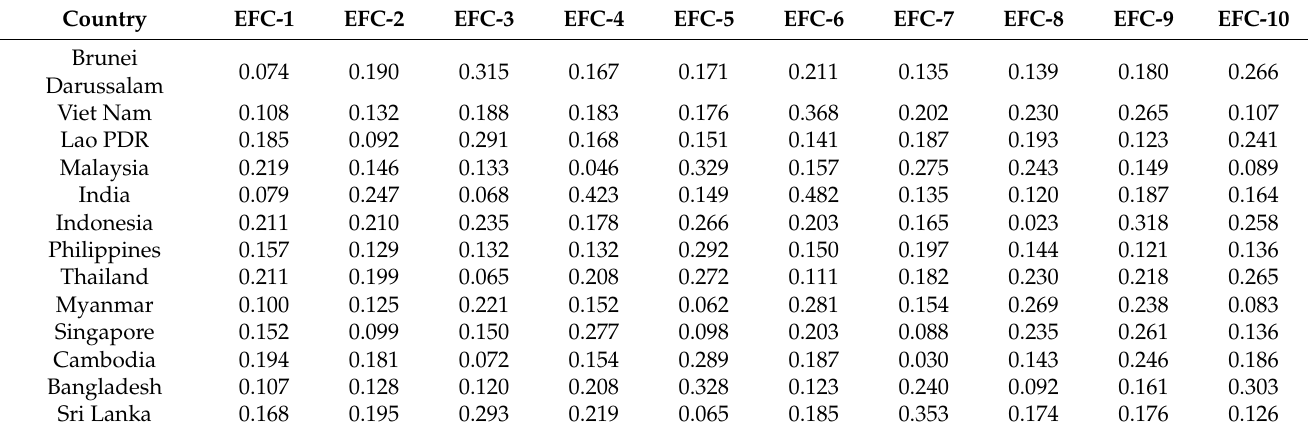
Table 6. Utility matrix.